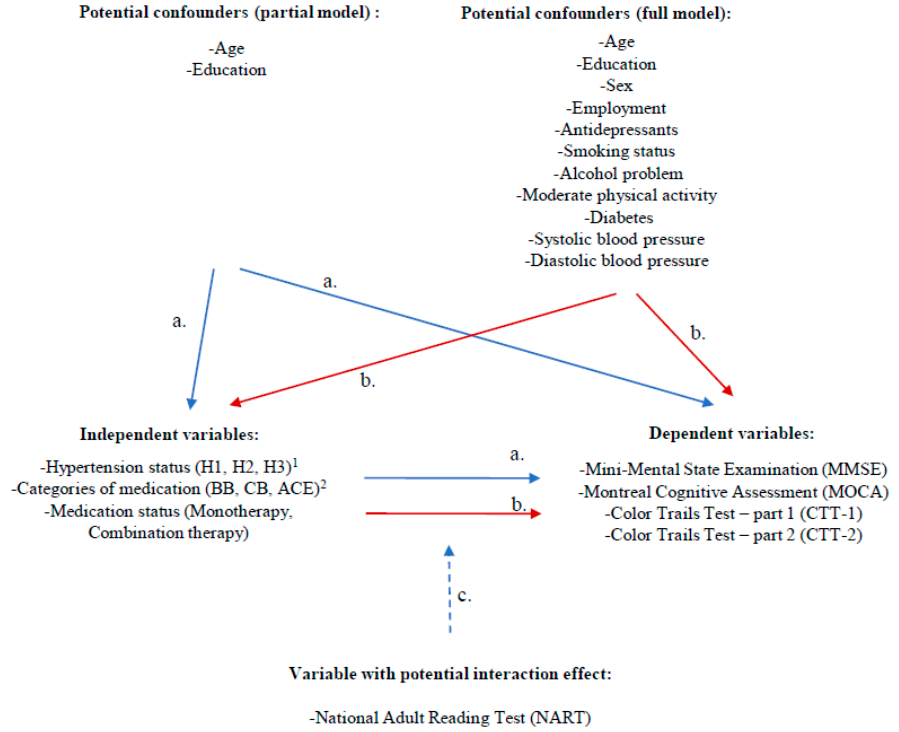
Figure 1. Analyses model investigating the associations between hypertension, categories of medication, medication status, and cognitive outcome measures cross-sectionally and longitudinally controlling for potential confounders and interaction e ff ect. a. Potential confounding variables in the partial models. b. Potential confounding variables in the full model. c. NART was used to examine the potential interaction e ff ect at W3 between the independent and dependent variables. 1 H1 = Non-hypertensive, H2 = Hypertensive without medication, H3 = Hypertensive with medication. 2 BB = Beta-blockers, CB = Calcium-channel blockers, ACE = Angiotensin-converting enzyme inhibitor.